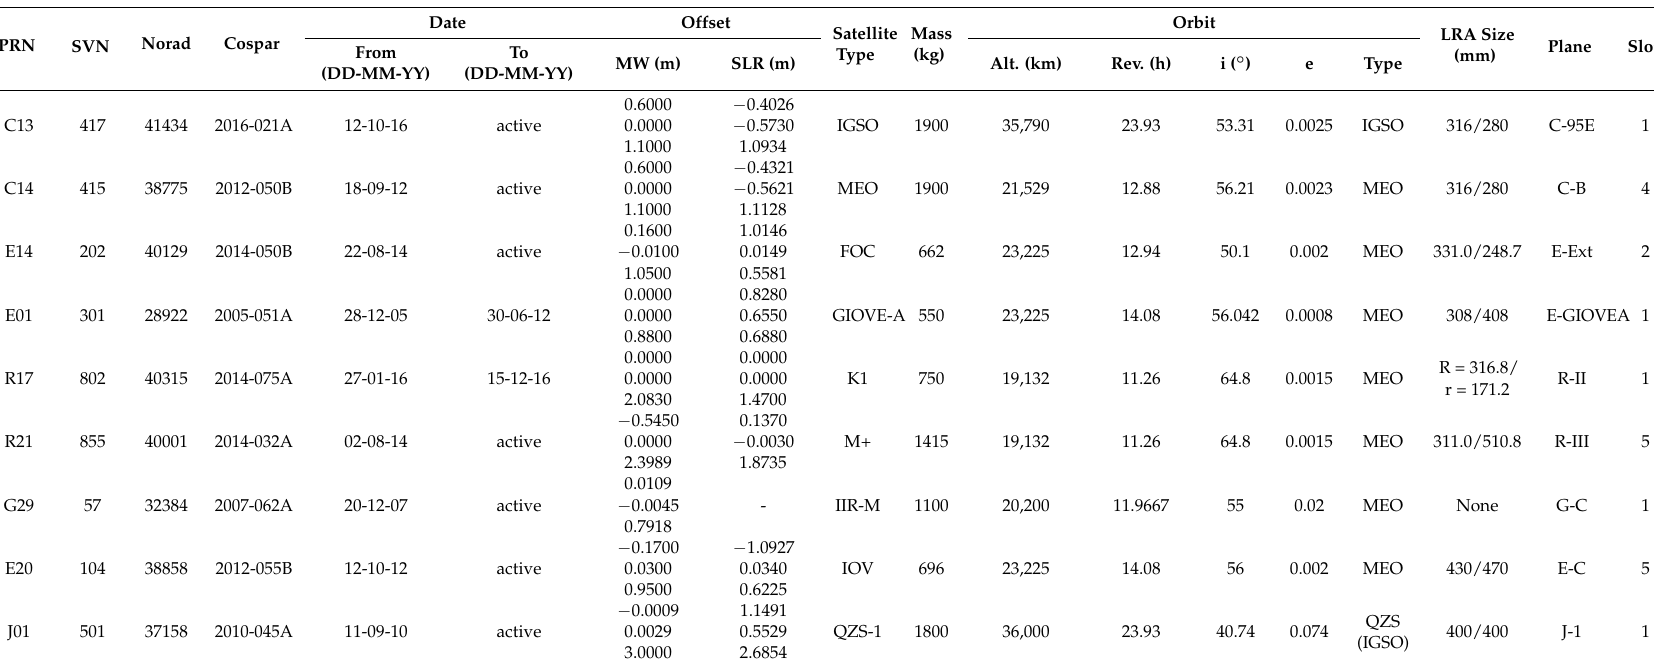
Table A3. Sample information about the satellites; possible to get from GOVUS database. Abbreviations used: MW offset, microwave antenna offset (m); SLR offset, laser retroreflector array offset (m); Alt., altitude (km); Rev., revolution period (h); i, inclination ( ◦ ); e, eccentricity.